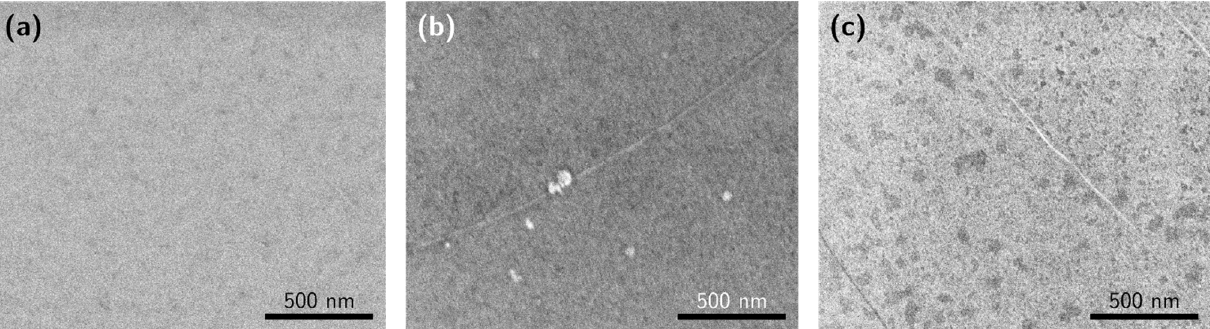
Figure 5. SEM images of the graphene films after different PMMA removal methods: ( a ) DUV exposure and dissolution in IPA/water, ( b ) dissolution in chloroform, ( c ) dissolution in acetone. Figure 6 shows topography and simultaneously obtained tunneling current images.